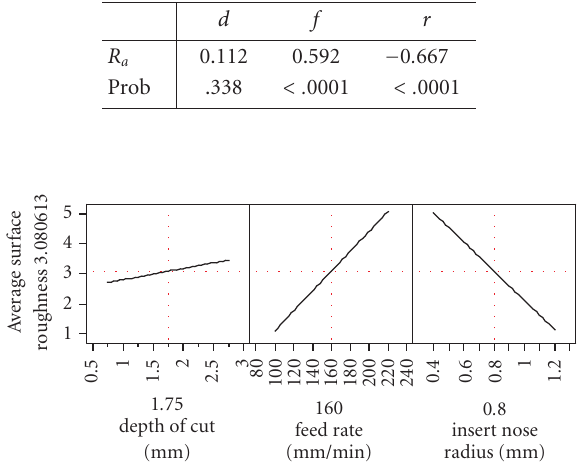
Table 6: Pearson correlation coe ffi cients to the surface roughness.